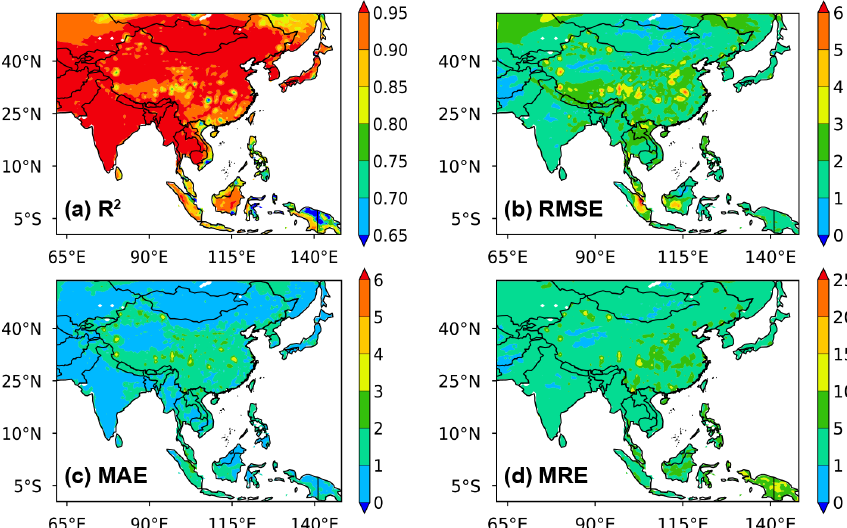
Figure 4. Spatial distributions of the performance statistics of the ML model with regard to (a) R 2 (unitless), (b) RMSE (ppb), (c) MAE (ppb), and (d) MRE (%) during 2014–2019 over Asia.